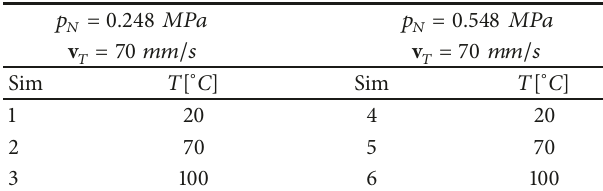
Table 1: Loading and boundary conditions in the simulation of a sliding rubber